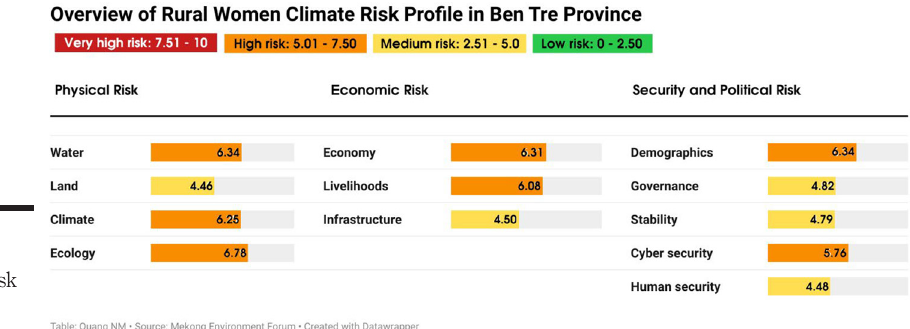
Figure 2. Women climate risk pro fi le